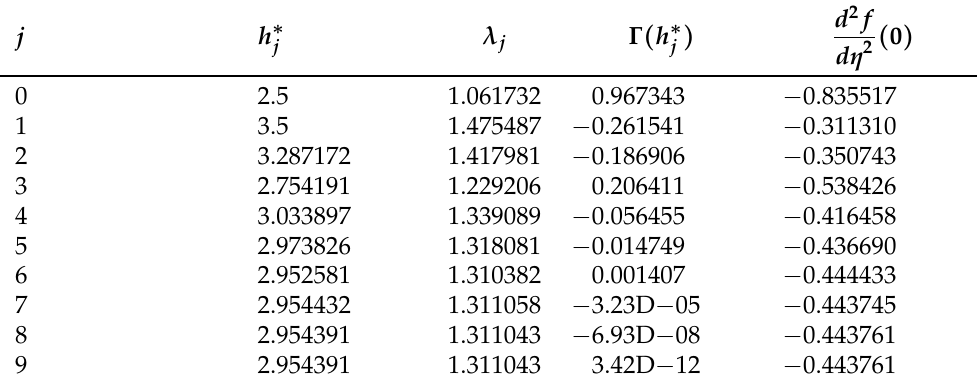
Table 1. Iterations and numerical results: secant root-finder.